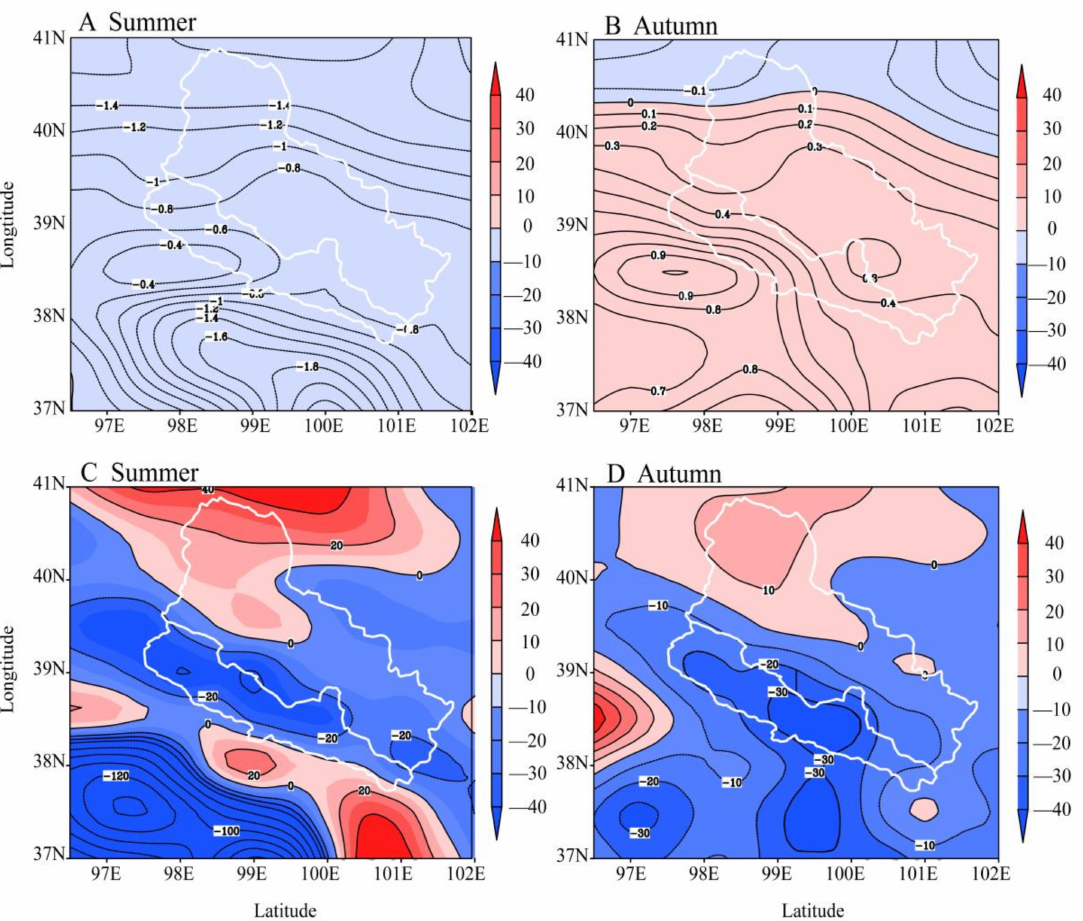
Figure 10. The differences (1998–2014 minus 1984–1997) in vertically integrated water vapor flux ( A , B ) and its divergence ( C , D ) for summer and autumn. The shadow indicates water vapor flux (unit: 10 − 7 g s − 1 cm − 1 hPa − 1 ) in Figure 10A,B, and the shadow indicates water vapor flux divergence (unit: 10 − 7 g s − 1 cm − 2 hPa − 1 ) in Figure